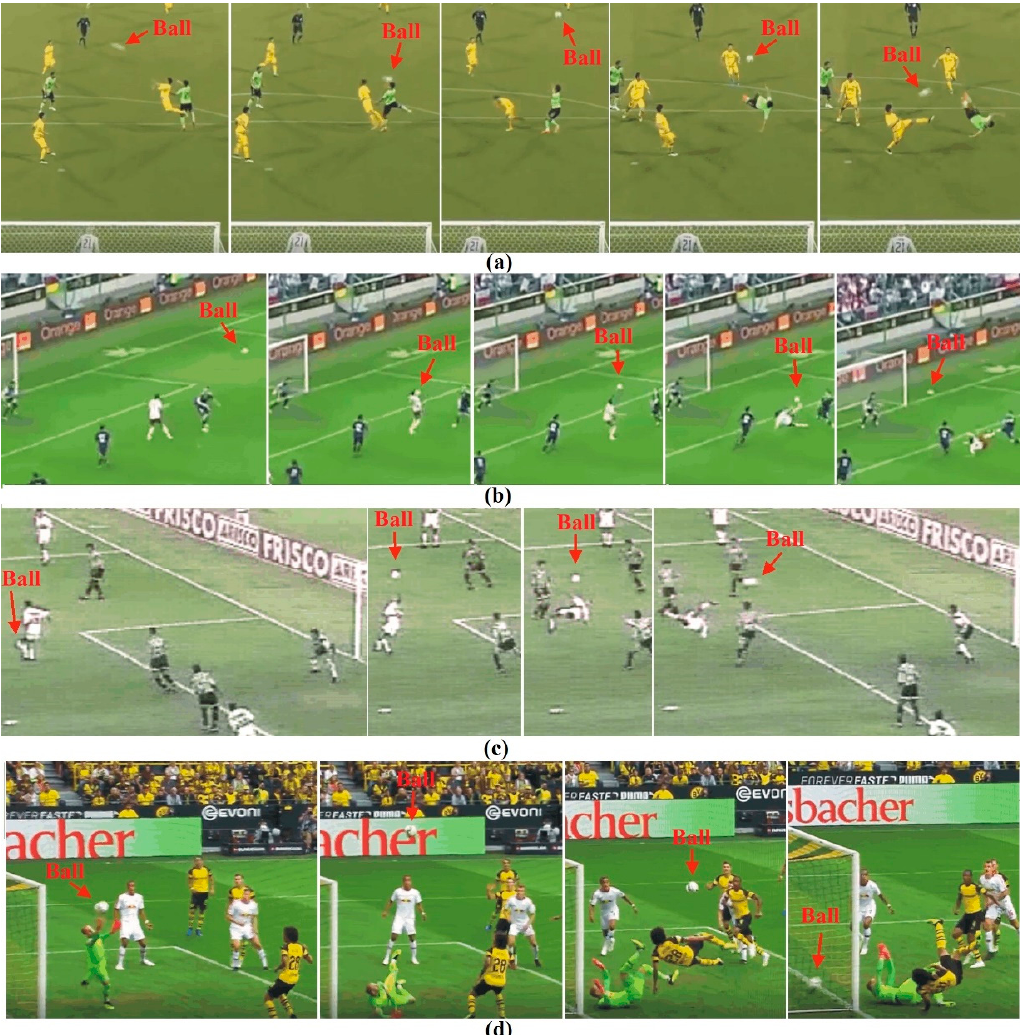
Figure 2. Successful examples of the jumping side volley in professional games. The common feature of the examples is a vertically travelling ball. The ball condition can be created by a player using ( a ) his head; ( b ) his chest; ( c ) his foot; or ( d ) set by another